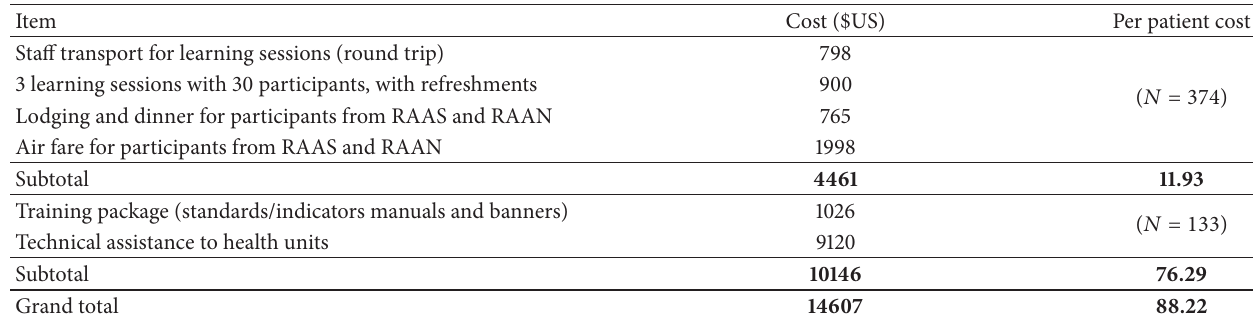
Table 3: Cost of the improvement collaboration for people with HIV and on